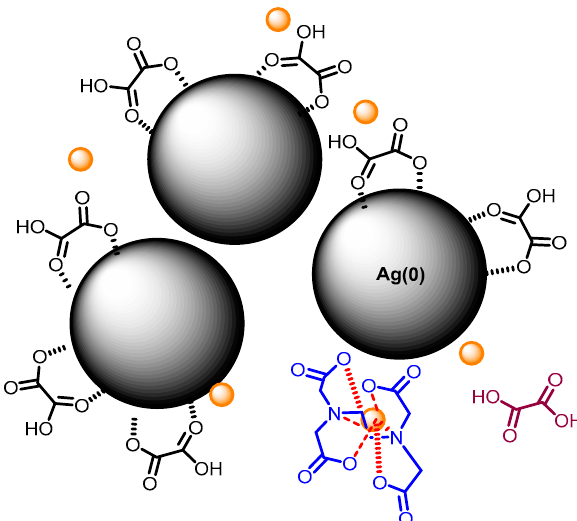
Figure 10. A speculated scheme of Cr (III) coordination with oxalate and EDTA on AgNPs surface. Small orange spheres represent Cr (III); molecules in blue represent the EDTA chelator in complex with Cr (III); molecules in black color represent the oxalate capping the AgNPs; molecule in purple color represents oxalate after being released from AgNPs surface.